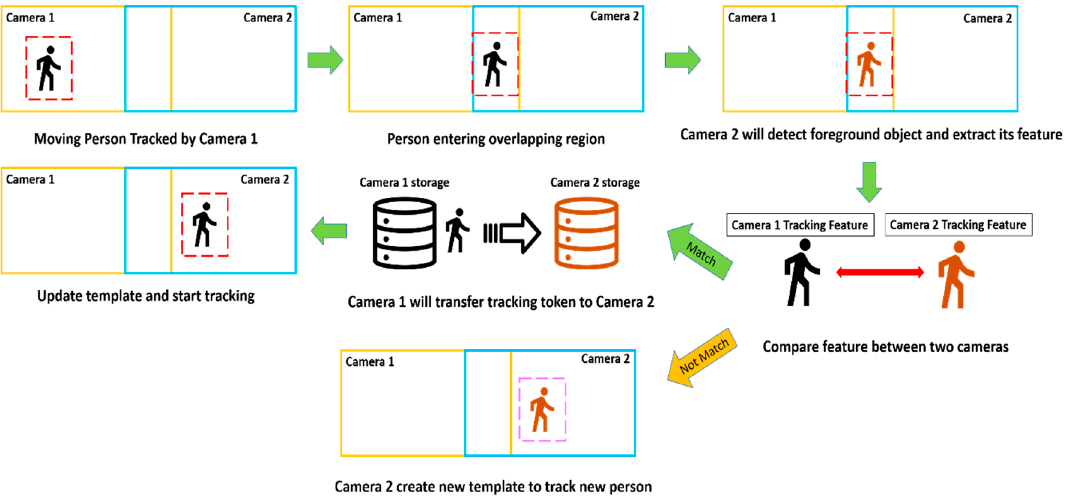
Figure 8. Cooperative Tracking between cameras.